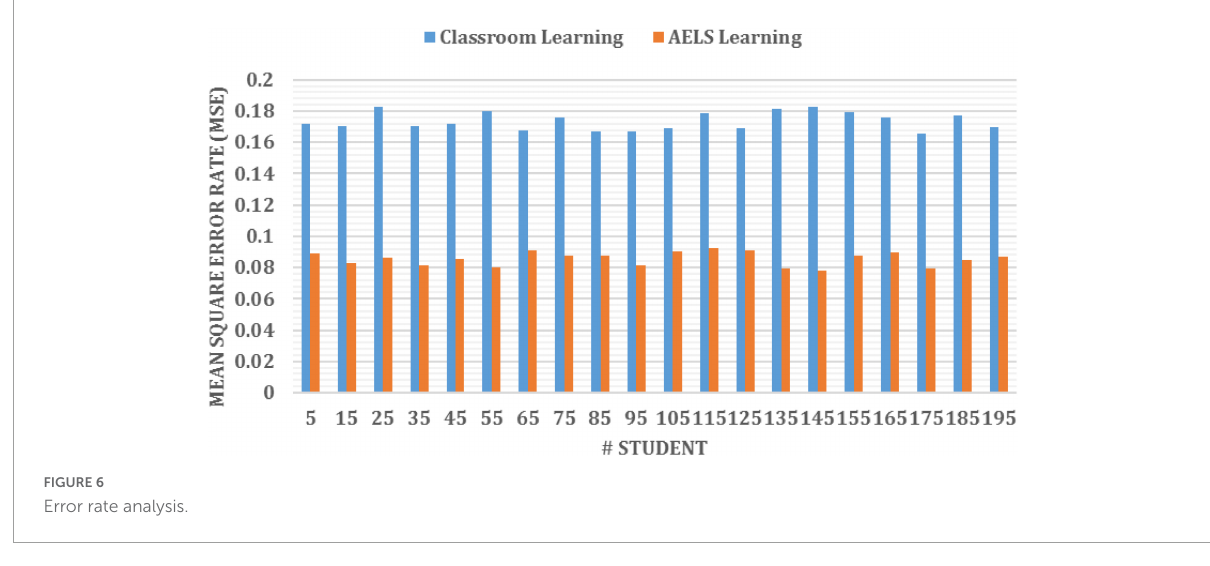
TABLE 2 Learning efficiency